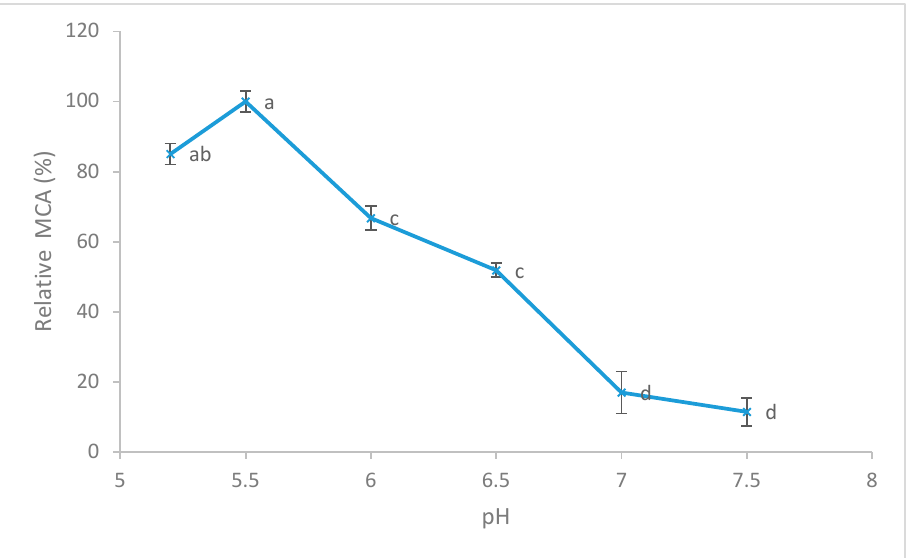
Figure 5. Effect of different pHs on milk-clotting activity of aqueous extract from ripe pulp kiwifruits. The percentage (%) of relative MCA represents the mean of three independent determinations performed in triplicate. The maximum value of MCA was 100%. Error bars represent standard deviations. Different lowercase letters (a, b, c and d) indicate a significant difference among samples at p < 0.05 (ANOVA with Tukey’s post hoc test).